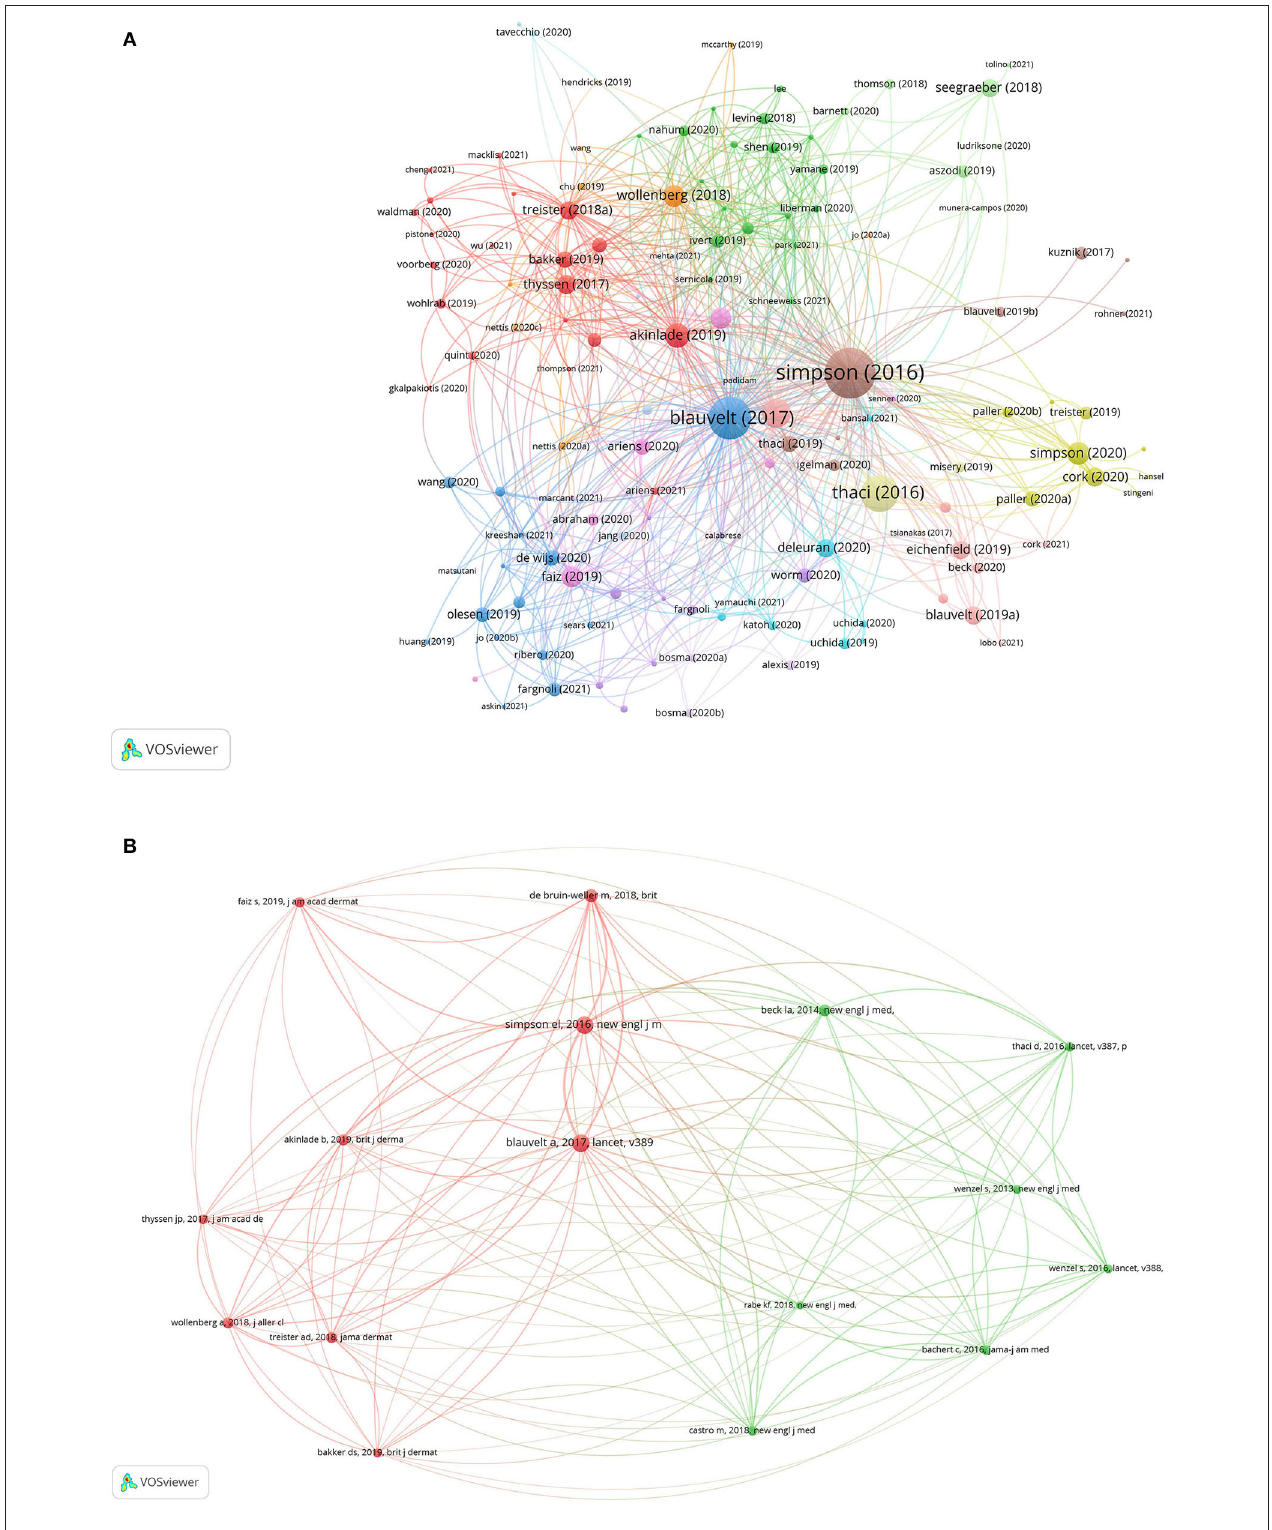
FIGURE 7 | The analysis of reference citations (A) and co-citations (B) .